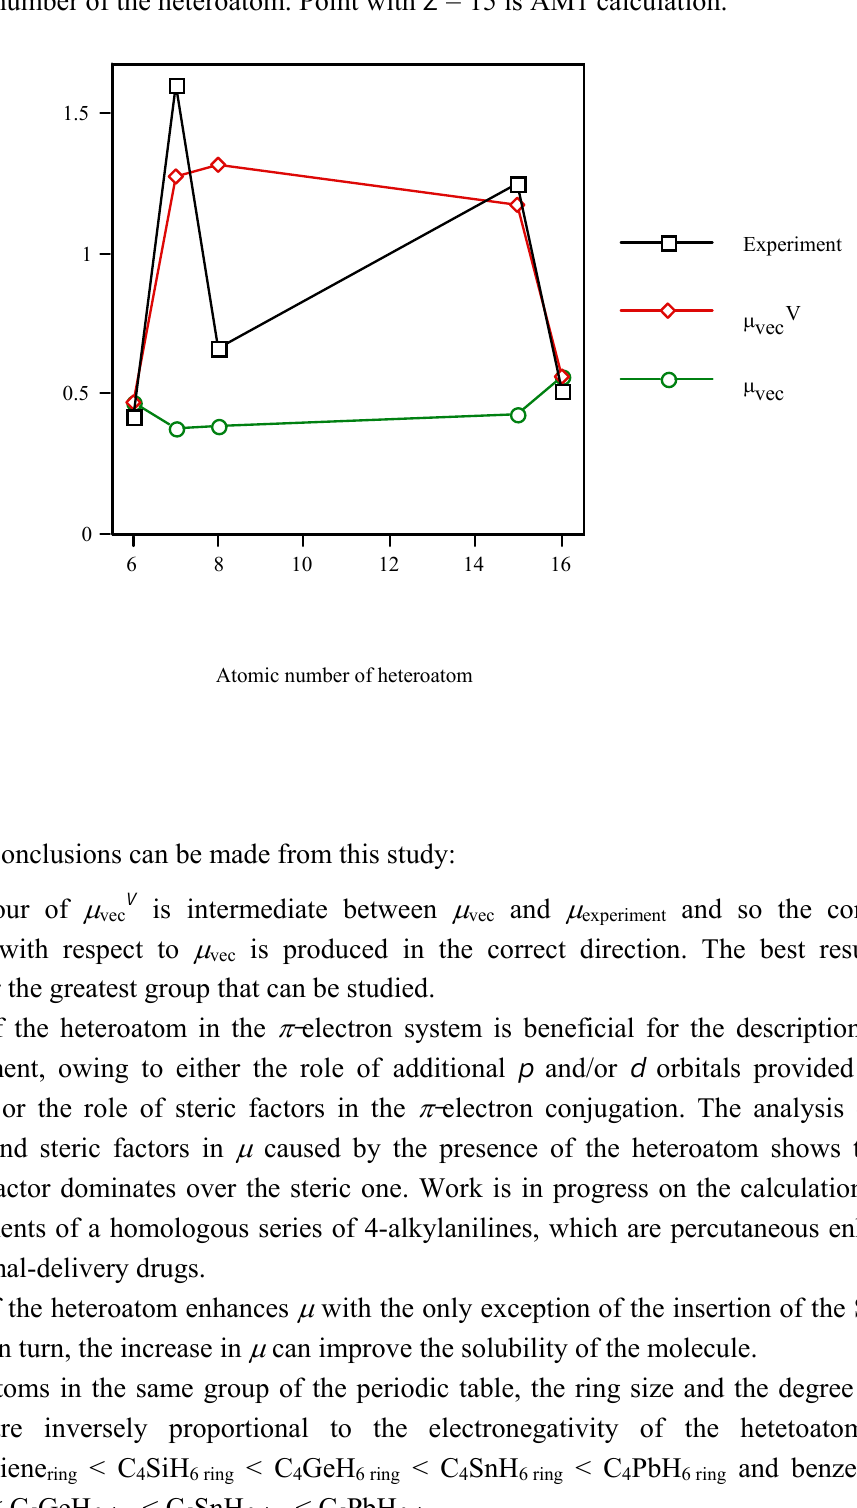
Figure 3. Dipole moment of the valence-isolectronic series of cyclopentadiene vs . the atomic number of the heteroatom. Point with Z = 15 is AM1